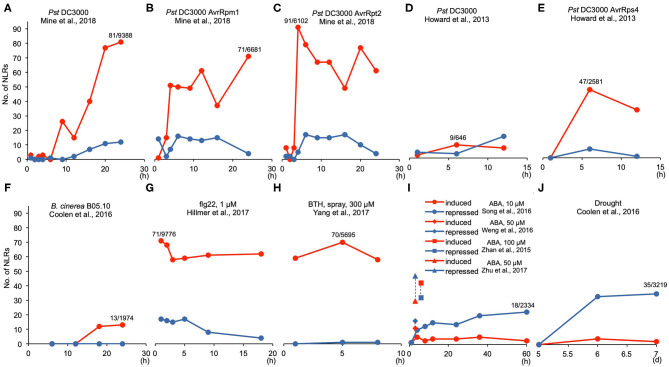
Transcript dynamics of NLR genes during biotic and abiotic stresses. (A–J) Line graphs showing the number of induced (red color) and repressed (blue color) NLR genes at each time point for different treatments. The numbers are made based on Table 1. For biotic stress treatments, the maximum number of induced NLR genes and the total DEG number are listed as induced NLR number/total DEG number above the corresponding time point. Similarly for abiotic stress treatments, the maximum number of repressed NLR genes and the corresponding total DEGs are listed. “h” indicates “hours” and “d” means “days”.